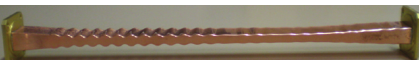
Figure 18: Photograph of the fabricated filter prototype in rectan- gular waveguide technology. Standard WR-90 ports are used.